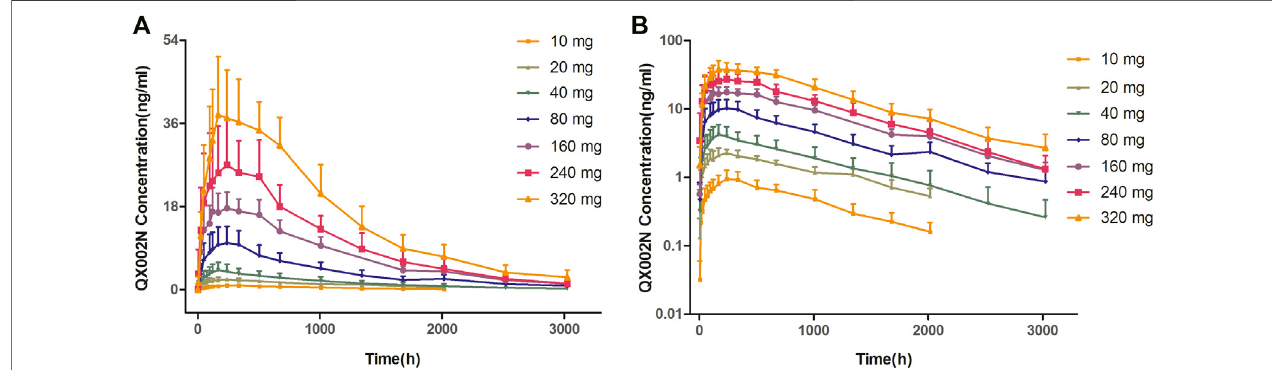
FIGURE 1| Meanconcentration – timecurvewithstandarddeviationaftersubcutaneousinjectionofasingleascendingdoseofQX002NinhealthyChinesevolunteers.